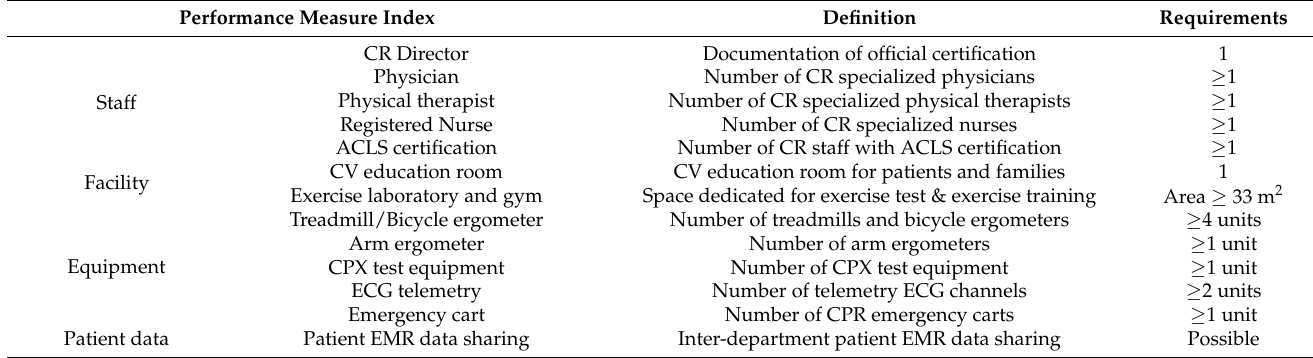
Figure 1. Locations of the Regional Cardiocerebrovascular Centers (RCCs) in South Korea. • Twelve RCCs which are included in this study. Two RCCs which were recently established and are not (cid:35) included in this study. Table 1. Performance Measure Index for the CR program of RCC (Requirements of the